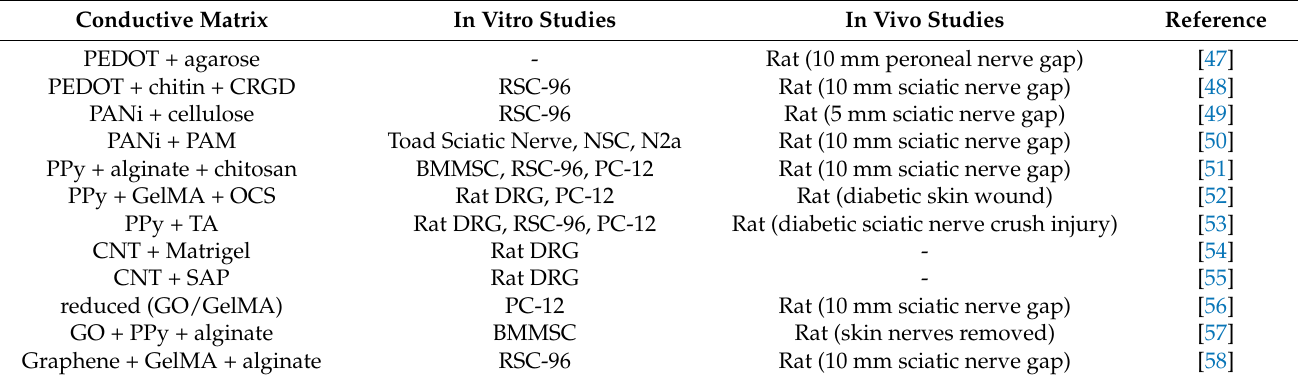
Table 1. Representative examples of electroconductive hydrogels for peripheral nerve regeneration. Abbreviations used in the table are found in the table